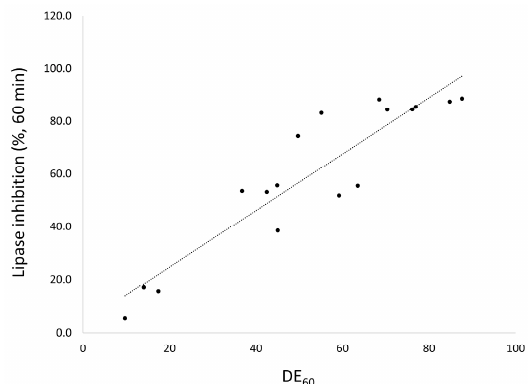
Figure 6. The relationship between DE 60 and lipase inhibition % at 60 min.